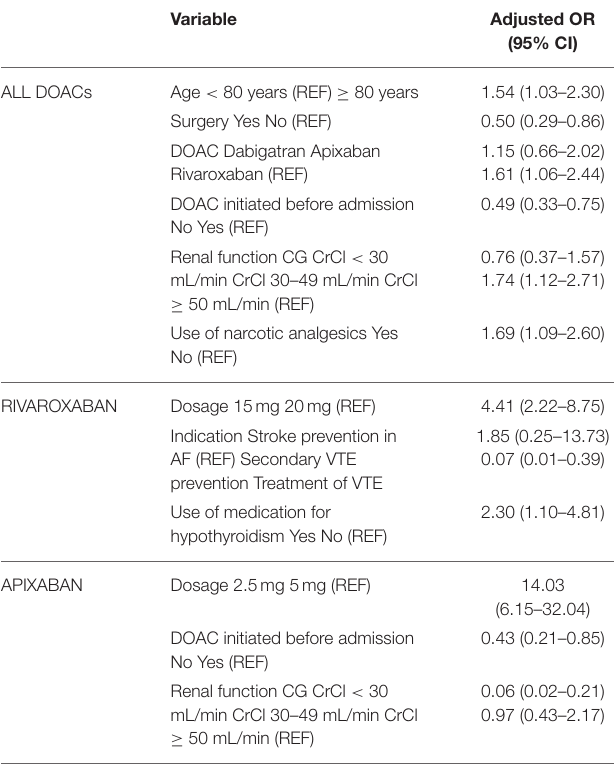
TABLE 3 | Multivariable logistic regression for the determination of risk factors that can lead to inappropriate